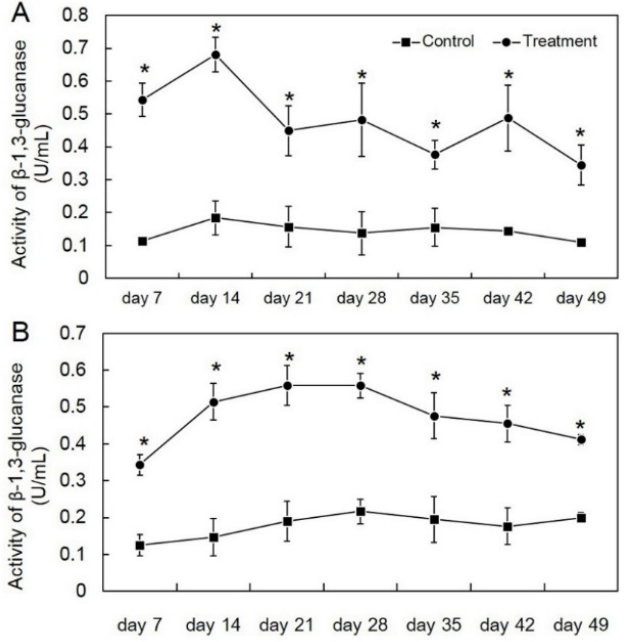
Figure 4. Activity of β -1,3-glucanase in the first crop ( A ) and second crop ( B ) through enzyme assay in Trichoderma asperelloides PSU-P1-treated muskmelon and control plants. * Indicates a signif- icant difference between treatment and control according to Student’s t -test with p < 0.05.